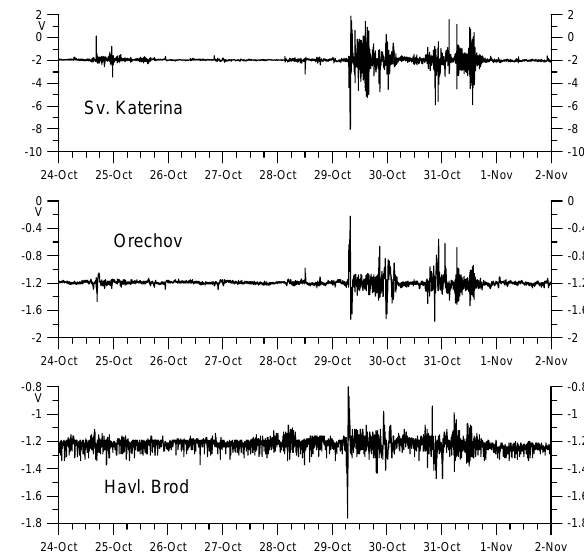
Fig. 4. Pipe-to-soil voltage recorded at the stations Orechov, Sv. Katerina and Havlickuv Brod between 24 October and 1 November 2003.